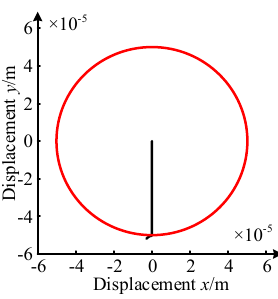
Figure 16. Axial trajectory under upper unit failure. netic pole with the contact and friction of a small tremor.